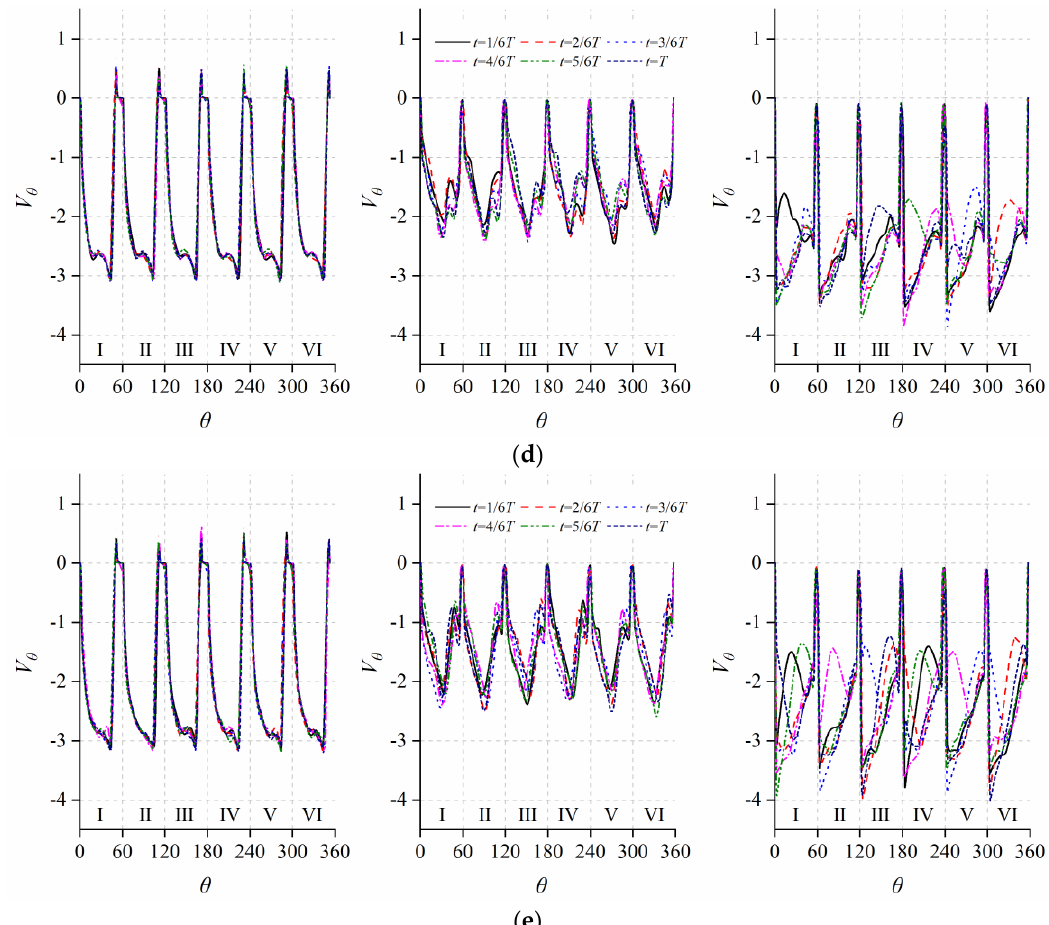
Figure 8. ( a – e ) Distributions of instantaneous normalized circumferential velocity along the circum- ferential direction at r* = 0.0 (left), r* = 0.5 (middle) and r* = 1.0 (right) for (from top to bottom) U rot /U ref = −0.5, −0.3, 0.0, 0.3 and 0.5.